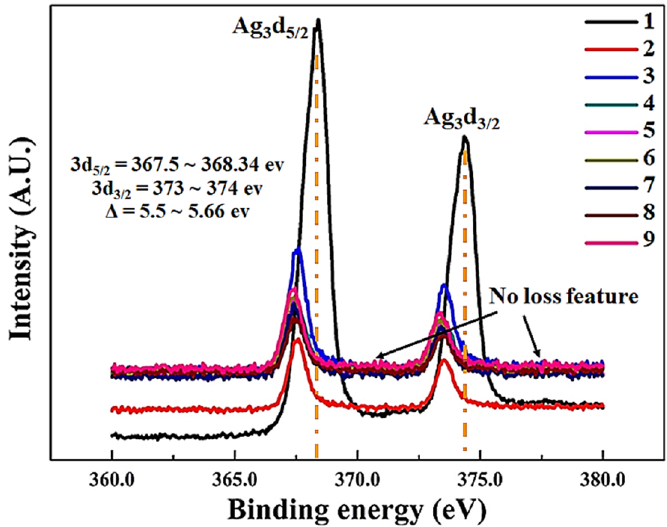
Figure 3. High-resolution X-ray photoelectron spectroscopy (XPS) Ag3d spectrum of thin films 1–9.